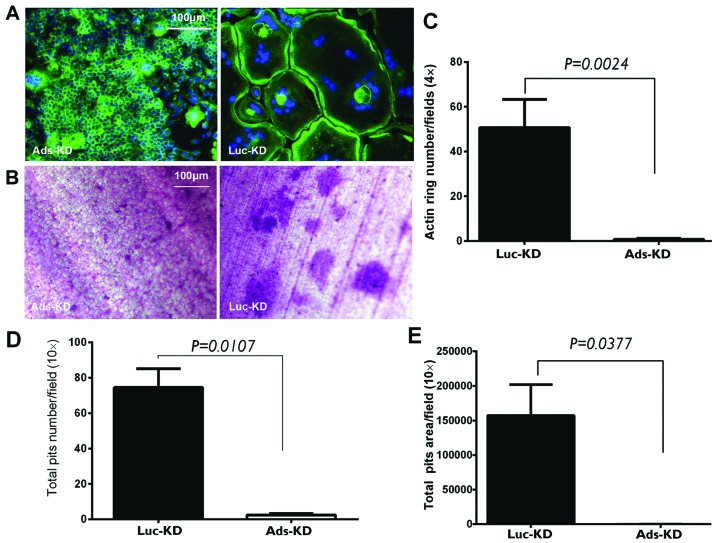
Adseverin (Ads) knockdown impaired RANKL-induced actin ring formation and bone resorption. (A) Actin rings were stained with Alexa 488-conjugated phalloidin. To visualize the nuclei, the cells were stained with 4′,6-diamidino-2-phenylindole (DAPI). Immunofluorescence images of osteoclast actin rings were visualized using confocal microscopy. Ads-knockdown cells have defective actin ring formation compared to Luc-knockdown cells. (C) The total number of rings/slide was counted. Luc-knockdown cells formed ~50 actin rings/field with clear and dense margins, whereas Ads-knockdown cells never formed actin rings.(B) Ads-knockdown and Luc-knockdown Raw264.7 cells stimulated with 60 ng/ml sRANKL were seeded onto dentin slices. On day 4, resorption pits formed on dentin slices were stained with 1% (w/v) toluidine blue. Ads-knockdown osteoclastic cultures had virtually no multinucleated osteoclasts on dentin disks (data not shown), and extremely small, seldomly-detected resorption pits. (D and E) The number and area of resorption pits were measured using ImageJ software. Results are expressed as the total area resorbed per dentine disc and the number of resorption pits. Luc-knockdown cells were capable of resorbing the dentin disc substrate at significantly higher rates. RANKL, receptor activator of nuclear factor-κB ligand.